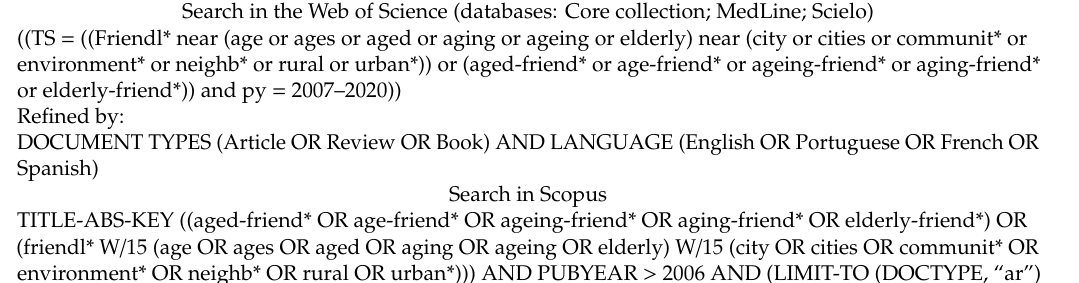
Table 1. Chain of terms used in the search according to